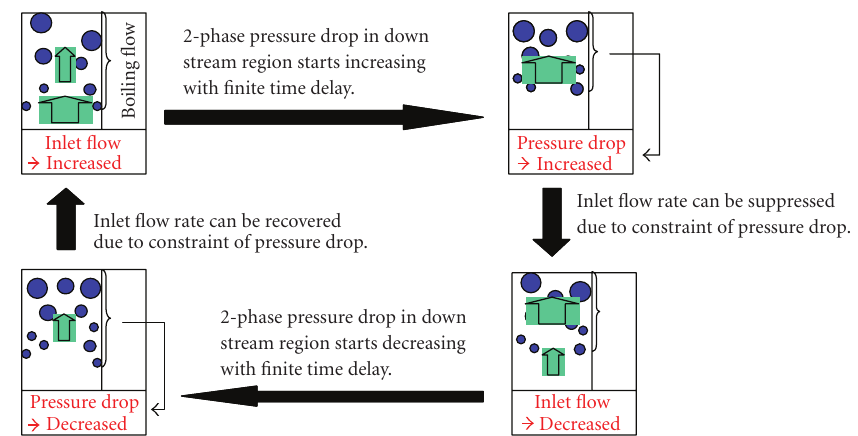
Figure 1: Schematic description for channel instability mechanism.